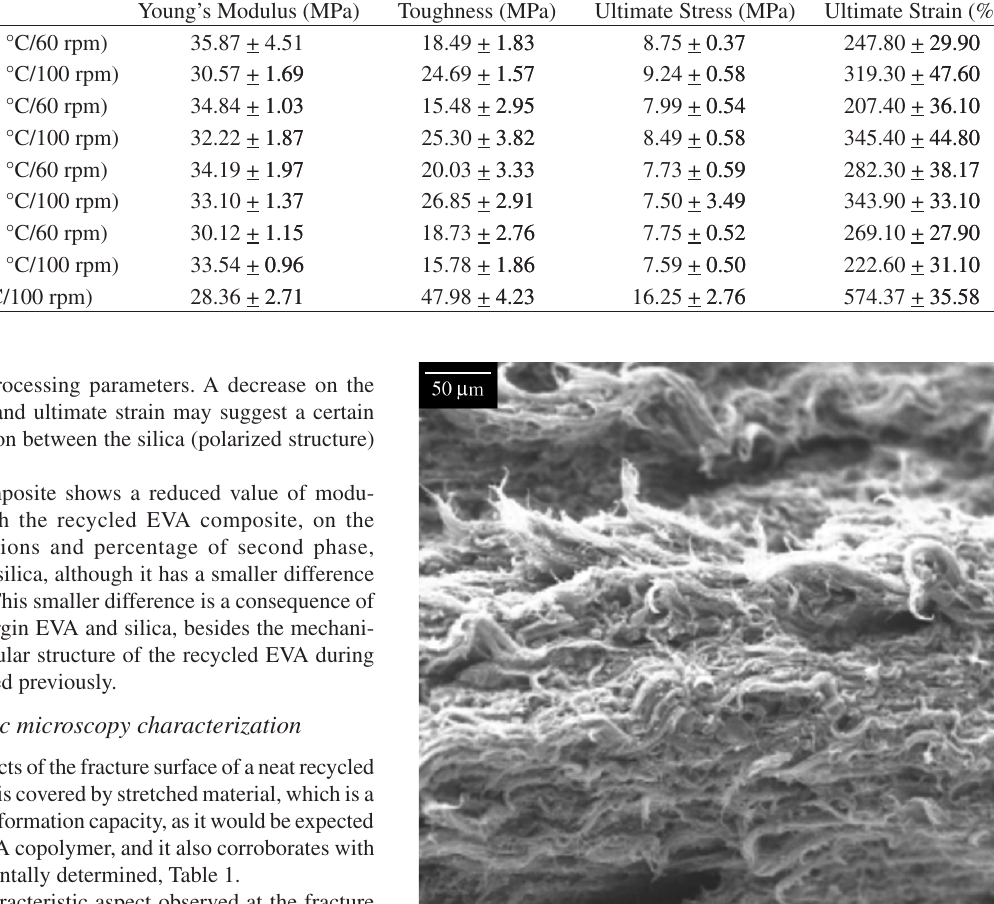
Table 2. Mechanical properties of the composites as a function of the processing variables. Material